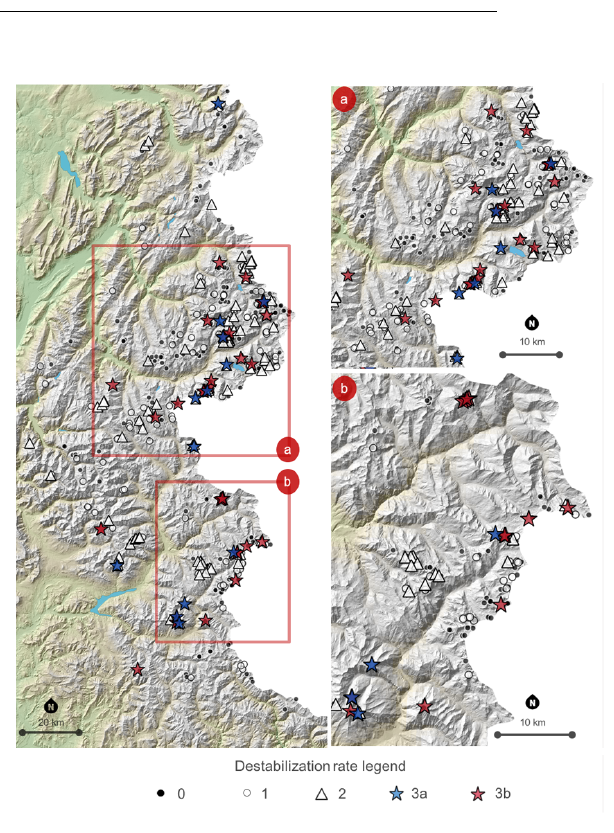
Figure 6. Map of active rock glaciers in France by rock glacier destabilization rating, with focus on the (a) Vaonise–Mont Cenis and (b) Ubaye ranges as most of potentially destabilized landforms were observed in these